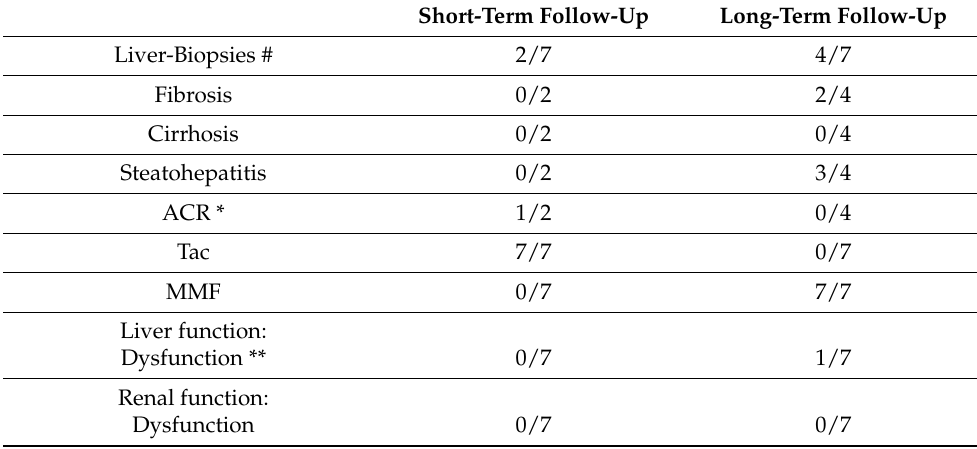
Table 4. Histological findings and immunosuppression for short- and long-term